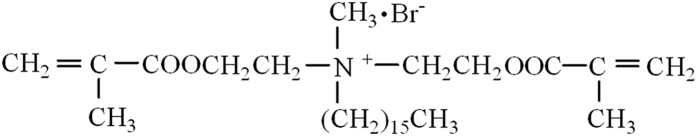
Structure of 2-methacryloxylethyl hexadecyl methyl ammonium bromide.